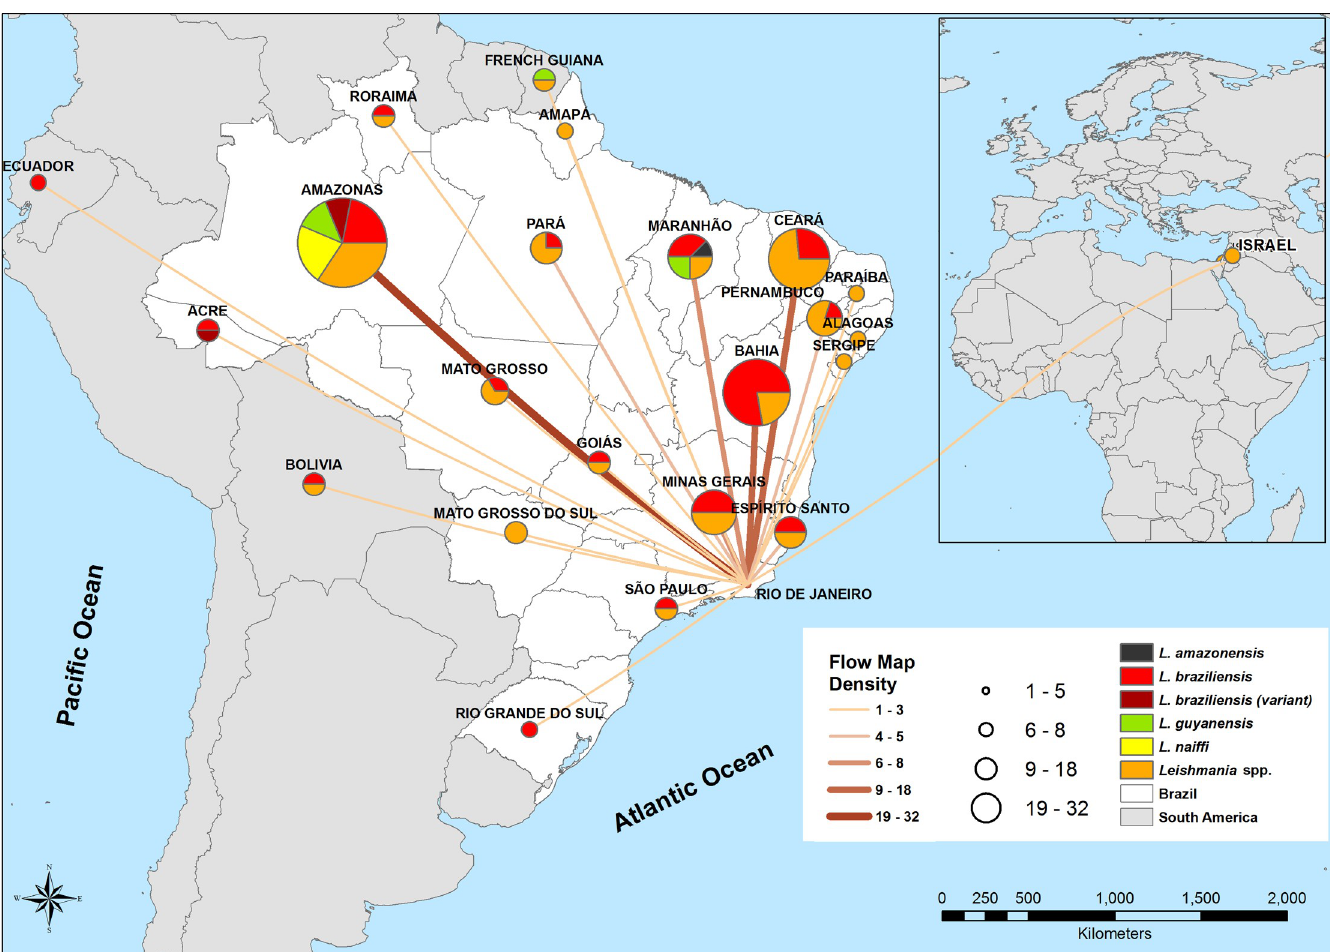
Fig 6. Map of flows to Rio de Janeiro state, with density of cases from other countries and Brazilian states. The density of cases was divided into five categories, differentiated by color and thickness. The lines are varied in width to represent the number of cases, with a broader line indicating greater flow. The width of the line is proportional to the flow. Pie charts represent the aggregated distribution of Leishmania species by country and state. This map was created using ArcGIS 9.1 software and cartographic bases obtained from the Brazilian Institute of Geography and Statistics (https://ibge.gov.br/).